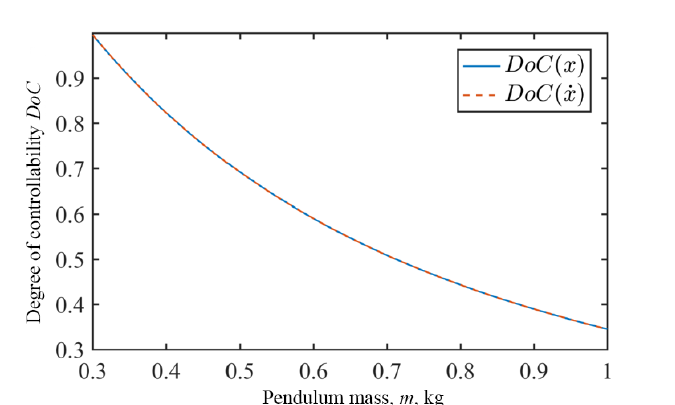
Figure 2. Change in the degree of controllability for x , ˙ x when increasing the mass of the pendulum m .